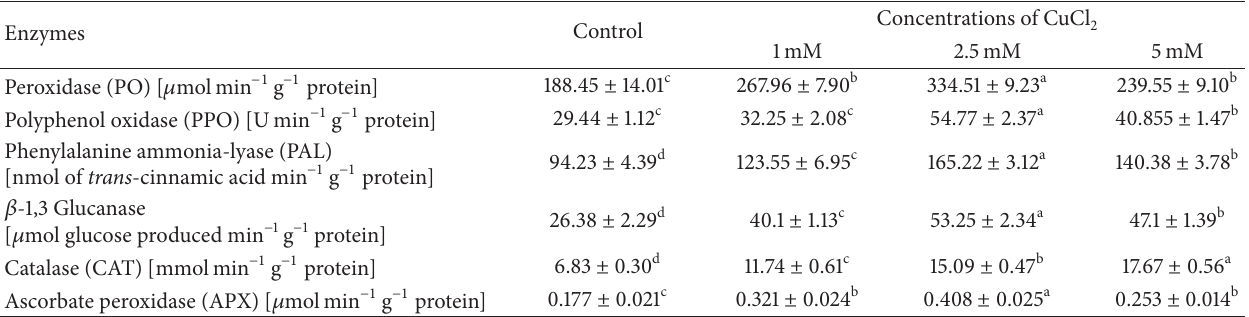
Table 1: Effect of CuCl on the production of defense and antioxidative enzymes in tomato plants. Values represent mean ± SE of three 2 separate experiments, each in triplicate.